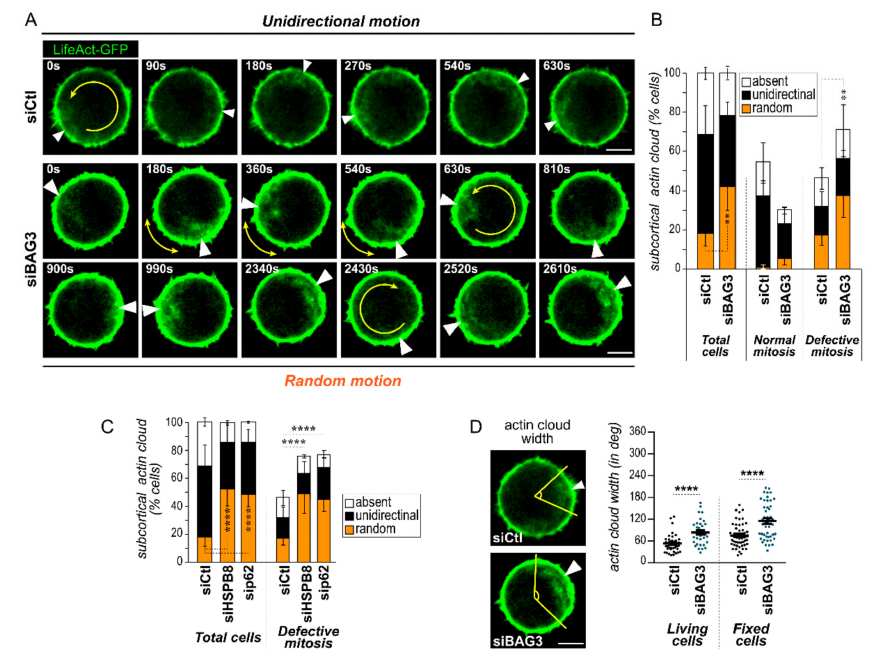
Figure 2. BAG3 and its mitotic partners regulate the dynamic and organization of the mitotic actin cloud. ( A ) Video stills taken from live-cell imaging of HeLa-H2B-RFP cells infected with LifeAct-GFP, showing representative dynamics of the subcortical actin cloud in control cells (siCtl; sustained and unidirectional motion), as compared to cells transfected with BAG3-specific siRNA (siBAG3; random motion); the white arrow points to the subcortical actin cloud and the yellow arrows indicate the direction of the revolving movement. See also Videos S1 and S2. ( B ) Quantification of the revolving movement behaviors for datasets represented in ( A ) within mitotic cell populations (total cells; left graph ), within subpopulations of cells with normal mitotic phenotypes, or within subpopulations of cells showing mitotic defects (defective mitosis: spindle rocking and delay in prometa-and metaphases; right graph side); means ± SEM ( n = 97 to 139 cells from N = 3 experiments). ( C ) Quantification of the revolving movement behaviors from time lapse analyses of HeLa-H2B-RFP expressing LifeAct- GFP and transfected with control siRNA (siCtl) or HSPB8- (siHSPB8) or p62/SQSTM1-specific siRNAs (sip62) within the indicated mitotic cell populations; please note that the control cell populations datasets are the same as in B. The data are the means ± SEM ( n = 97 to 139 cells from N = 3 experiments). Statistical analyses were performed using the chi-square test; **, p < 0.01; ****, p < 0.0001. ( D ) Representative confocal images showing the organization of the actin cloud; the angular widths are delineated by yellow lines and positions of the actin clouds are pointed out by white arrowheads. Scale bar: 10 µ m. The graph shows the actin cloud angular widths in live cells expressing LifeAct-GFP ( left ) or in fixed cells stained with fluorescent phalloidin ( right ), as measured using the method described in Figure S2; means +/ − SEM of n = 35 and 53 cells from 3 experiments. Statistical analysis was performed using the Mann–Whitney test; ****, p <